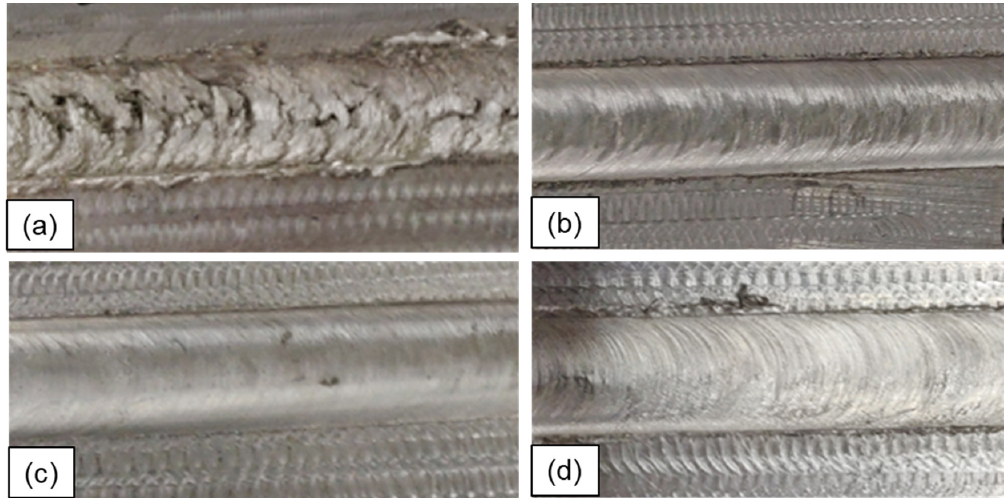
Figure 4. Top surface of the plates processed using ( a ) anti-clockwise (ACW) scroll shoulder having a plain cylindrical pin, ( b ) plain shoulder having a plain cylindrical pin, ( c ) plain shoulder having a left-hand threaded cylindrical (LHT) pin, and ( d ) plain shoulder having a right-hand threaded cylindrical (RHT) pin.